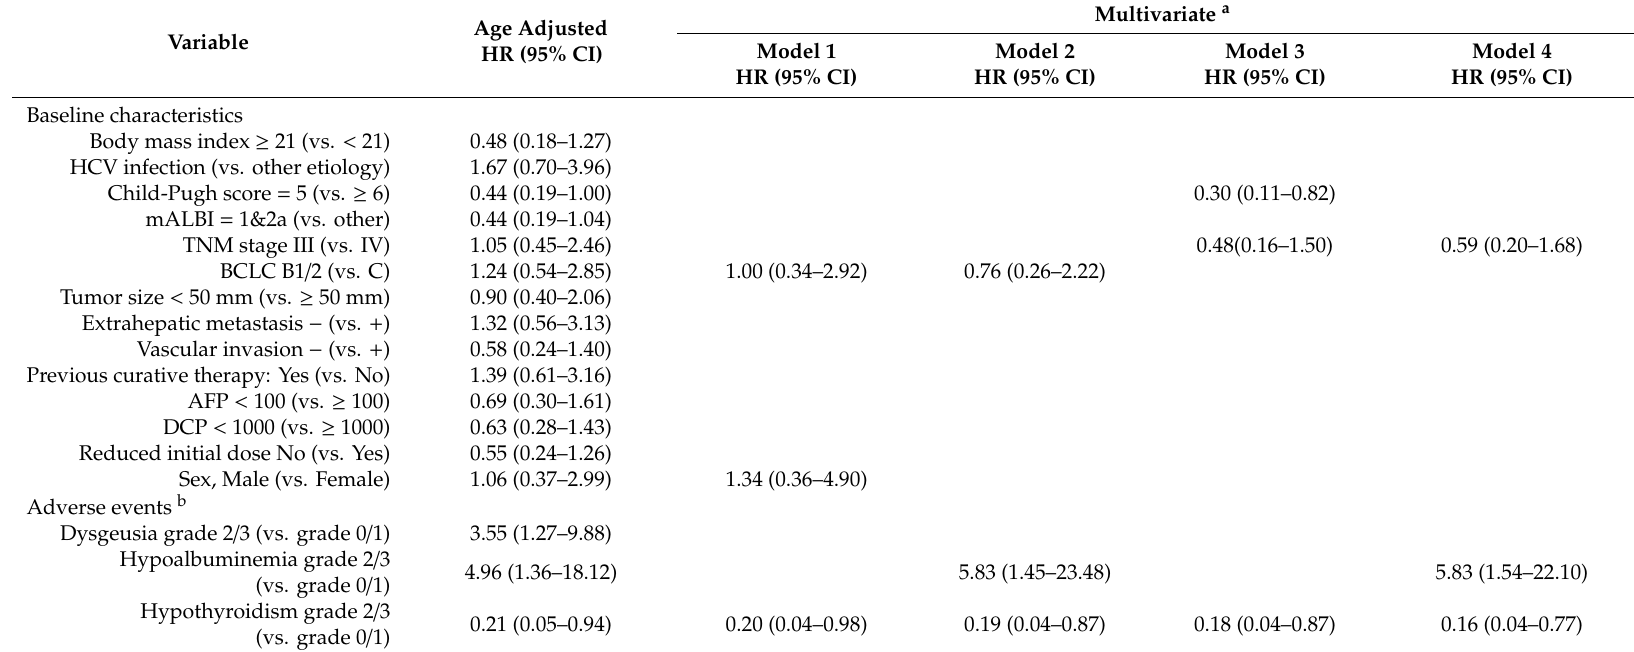
Table 4. Baseline demographic and clinical variables and adverse events associated with overall